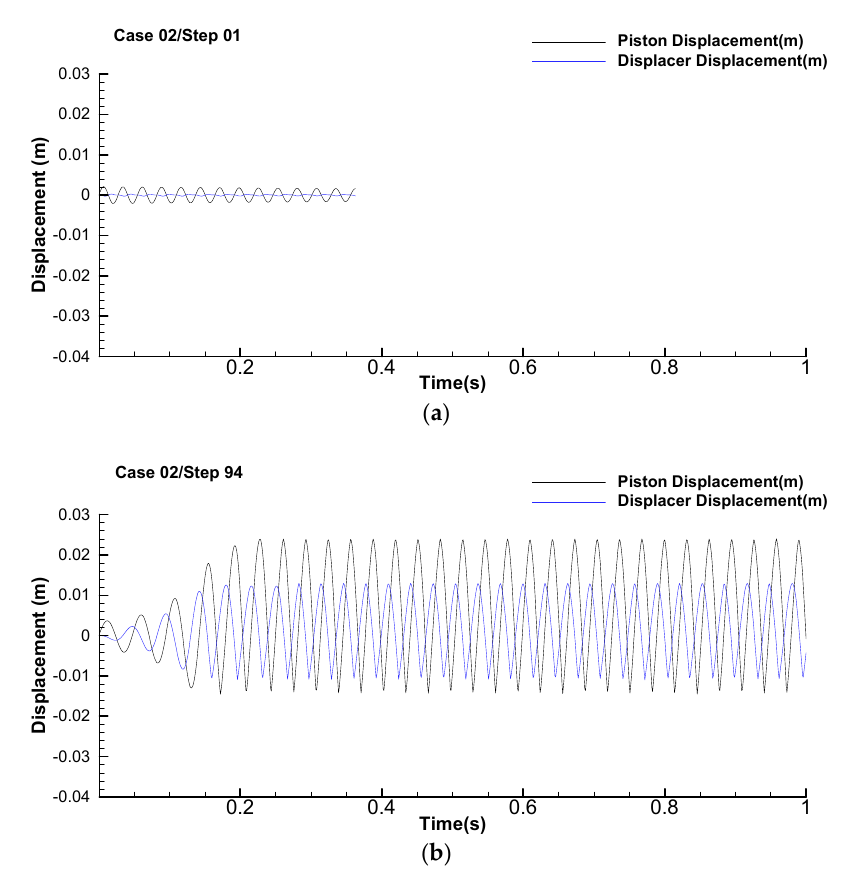
Figure 9. Optimization with the VSCGM + the wake-up and backward-comparison strategies for the maximum stroke of the displacer in Case 2: ( a ) initial design; ( b ) design generated by the VSCGM and the backward-comparison strategy.